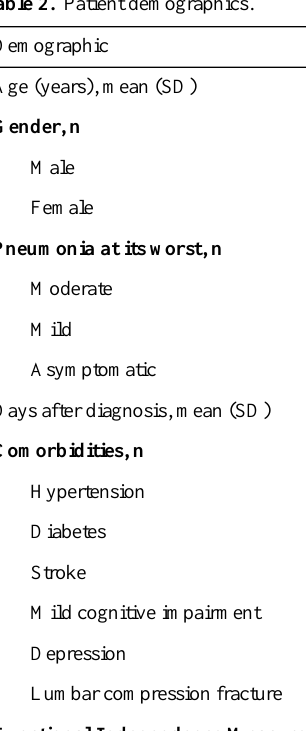
Table 2. Patient demographics.